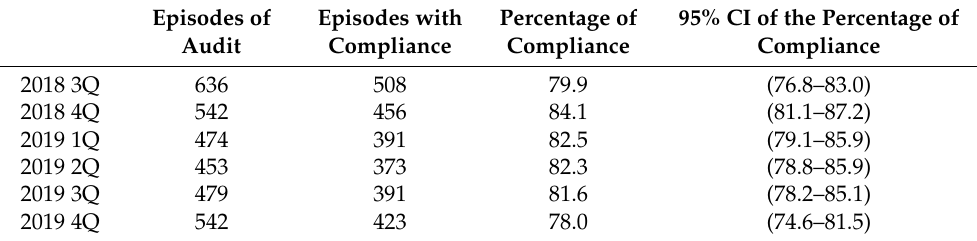
Table 1. Compliance with the practice of directly observed hand hygiene applied to the conscious hospitalized